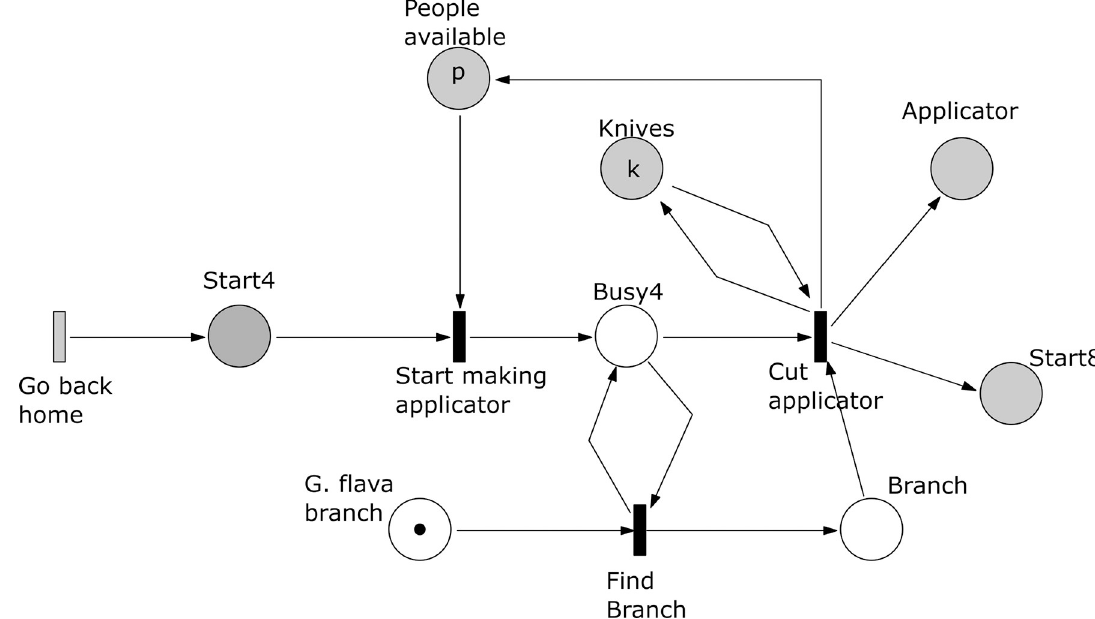
Fig 15. Subprocess 4 Make Applicator of the O . Schinzii model.